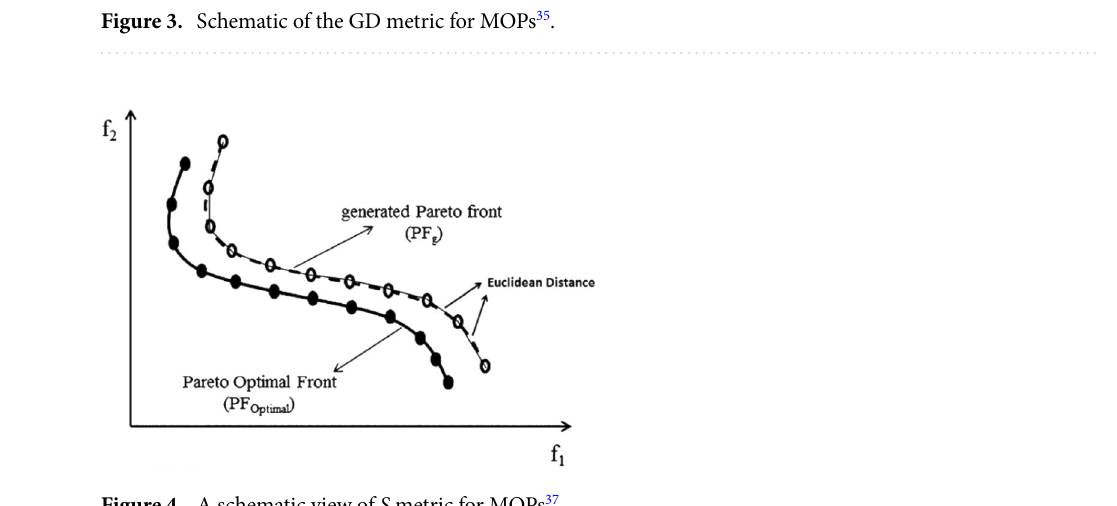
Figure 4. A schematic view of S metric for MOPs 37 .